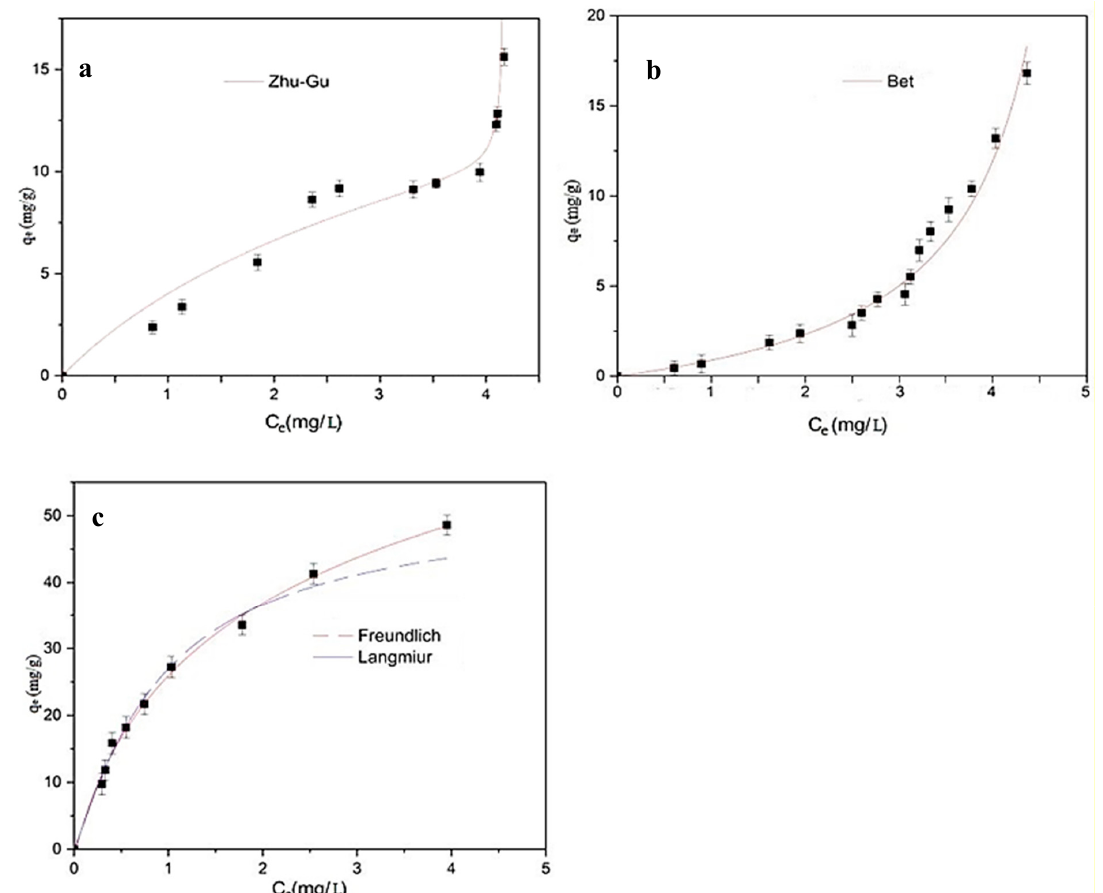
Figure 7. Experimental equilibrium results together with fittings to the considered models for the adsorption isotherm of SMX onto MY ( a ), MY@NIPs ( b ), and MY@MIPs ( c ) in ultrapure water.